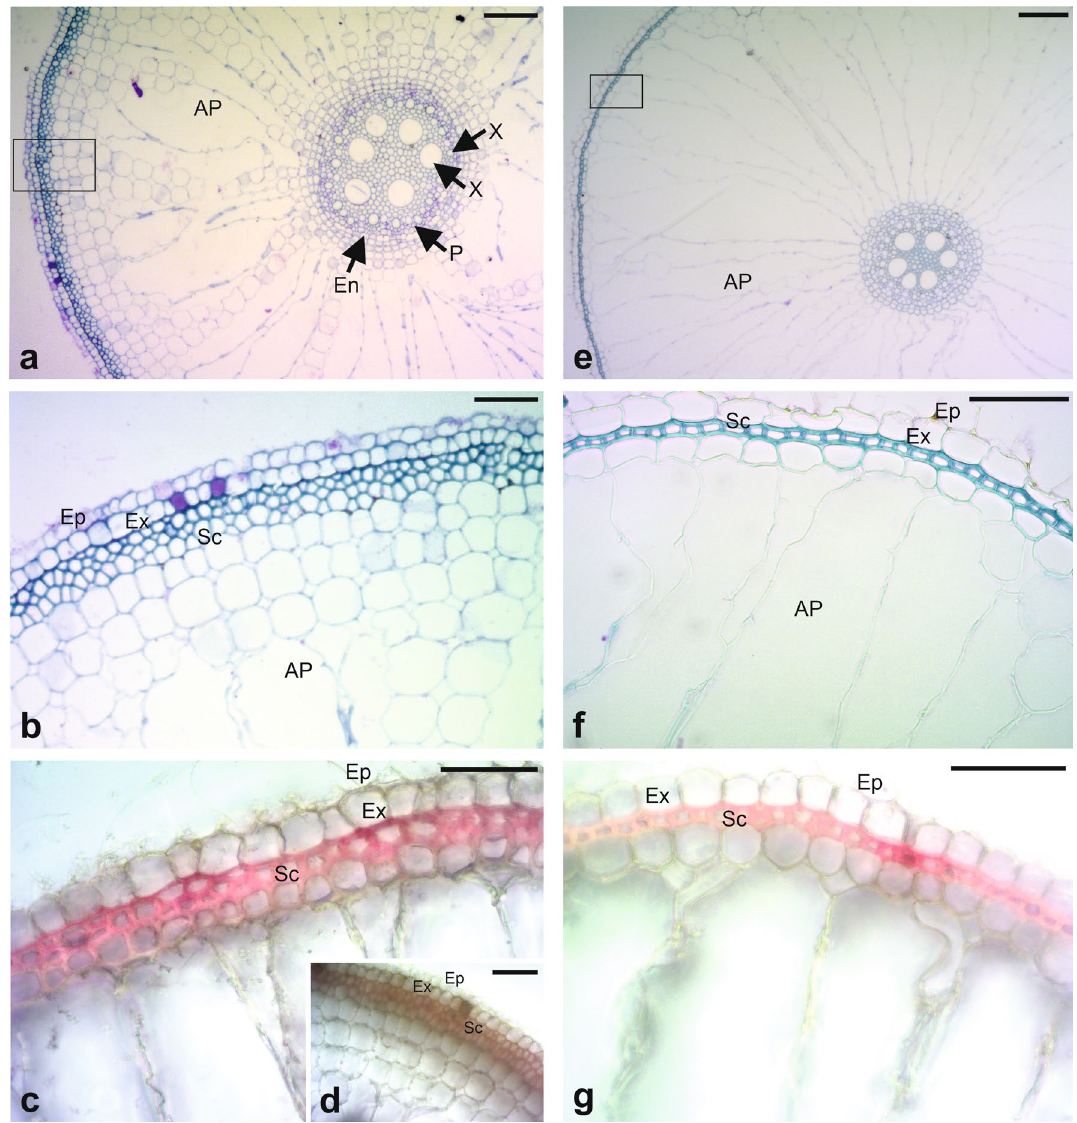
Figure 3. Root anatomy of rice cultivars resistant [‘Dawn’ = ( a – d )] and susceptible [(‘BRS Pampa CL’ = ( e – g )] to the South American rice water weevil Oryzophagus oryzae at 25 Days After Flooding (DAF). ( a ), ( e ) Overview, box showing the differentiation among root layers; ( b ), ( f ) Sclerenchyma cells arranged into 3-layers and 1-layer in the resistant and susceptible cultivars, respectively; ( c ), ( d ) and ( g ) Lignin detection in sclerenchyma cells by histochemical methods (red color) [( c ) ‘Dawn’ infested plant and ( d ) ‘Dawn’ non-infested plant]. AP = aeriferous parenchyma or aerenchyma; Ep = epidermis; Ex = exodermis; En = endodermis; Sc = sclerenchyma; X = xylem; P: phloem Bars: 200